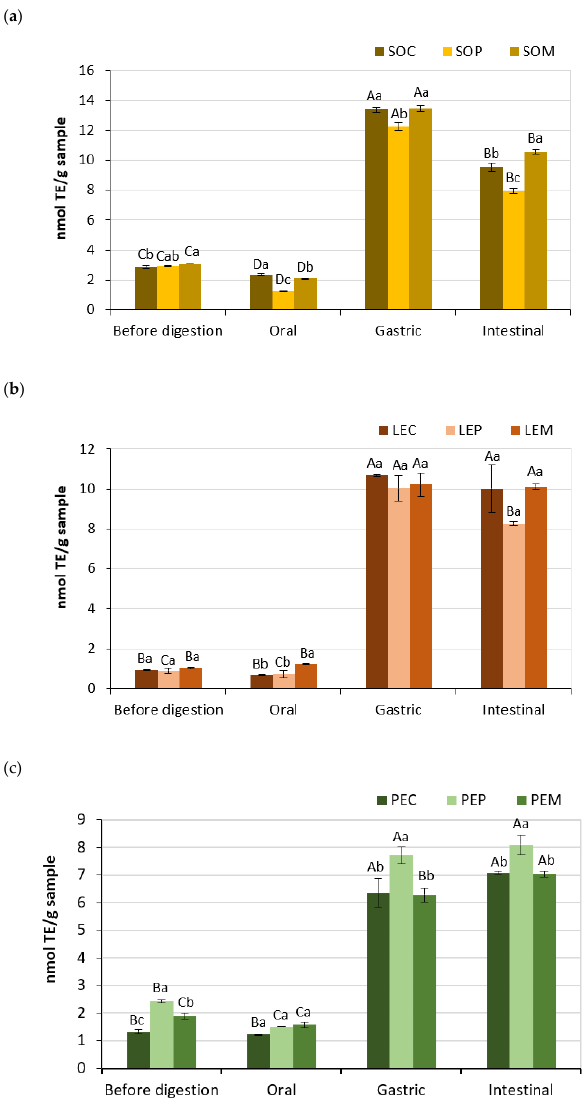
Figure 4. ABTS ( 2,2′ -azino-bis(3-ethylbenzothiazoline-6-sulfonic acid) diammonium salt) radical scavenging capacity of legume pastes from ( a ) soybean, ( b ) lentil, and ( c ) pea subjected to different cooking methods (SOC, ordinary cooked soybean; SOP, pressure-cooked soybean; SOM, microwave-cooked soybean; LEC, ordinary cooked lentil; LEP, pressure-cooked lentil; LEM, microwave-cooked lentil; PEC, ordinary cooked pea; PEP, pressure-cooked pea; PEM, microwave-cooked pea). Capital letter indicates significant differences between phases (before digestion, oral, gastric, and intestinal digestion) within the same legume sample and treatment ( p < 0.05), whereas lowercase letter indicates significant differences between treated samples (cooking, pressure cooking, and microwave) within the same legume and phase ( p < 0.05).